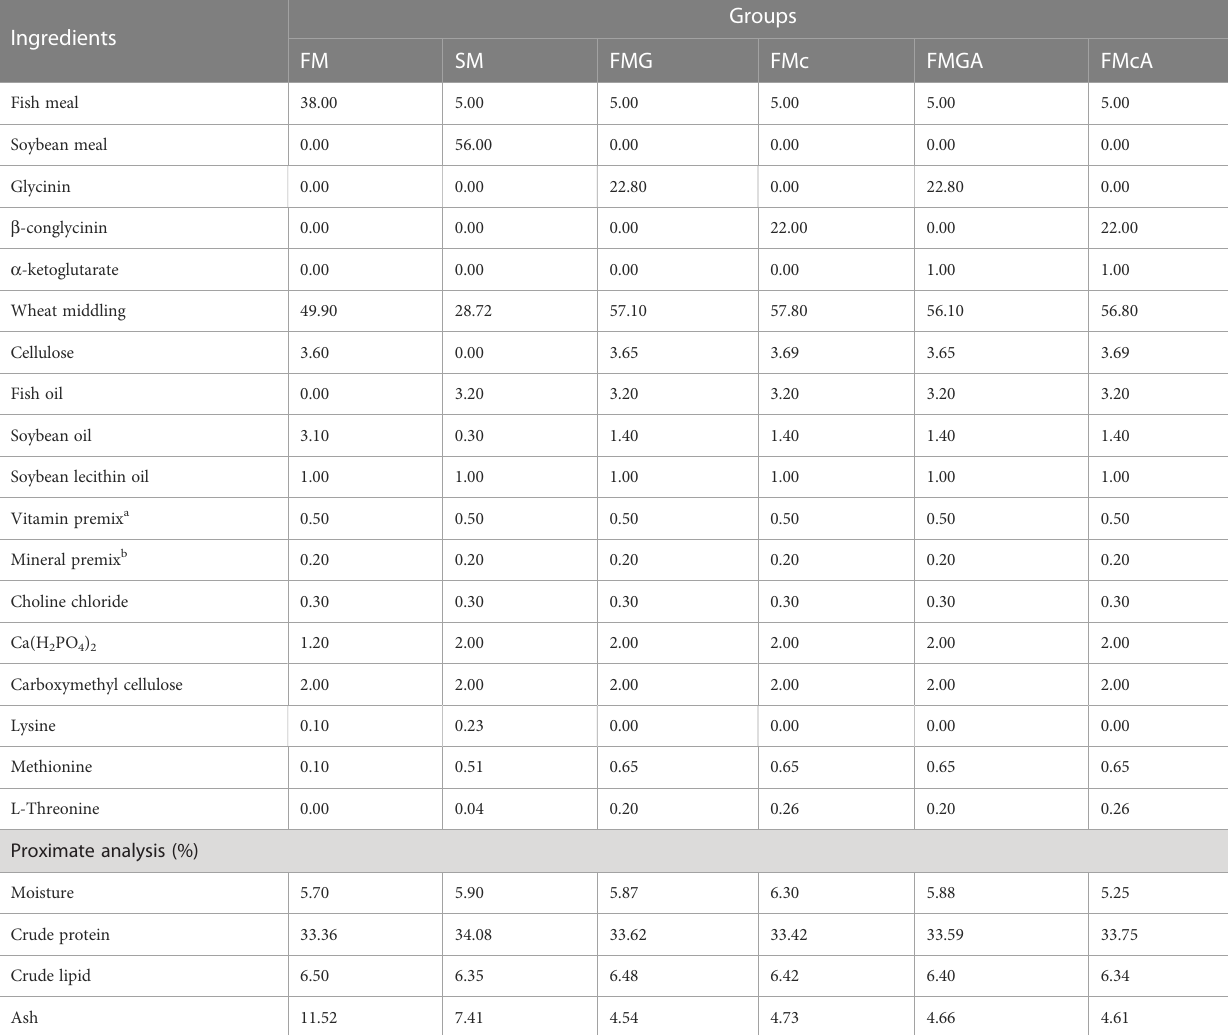
TABLE 1 Formulation of the experimental diets fed to Mirror carp ( Cyprinus carpio ), and their analyzed nutrient